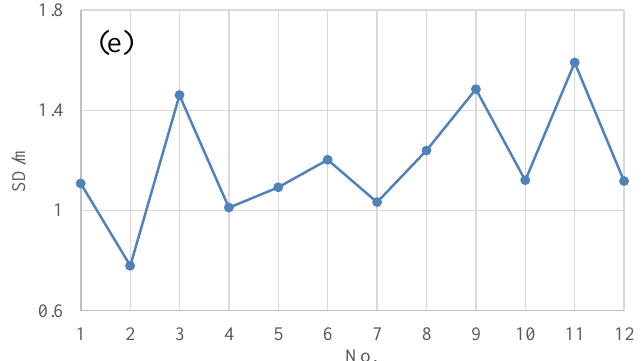
Figure 6. The trend of the concentration of water quality parameters in Dashahe Reservoir: ( a ) Chl-a, ( b ) CODMn, ( c ) TN, ( d ) TP, and ( e ) SD.